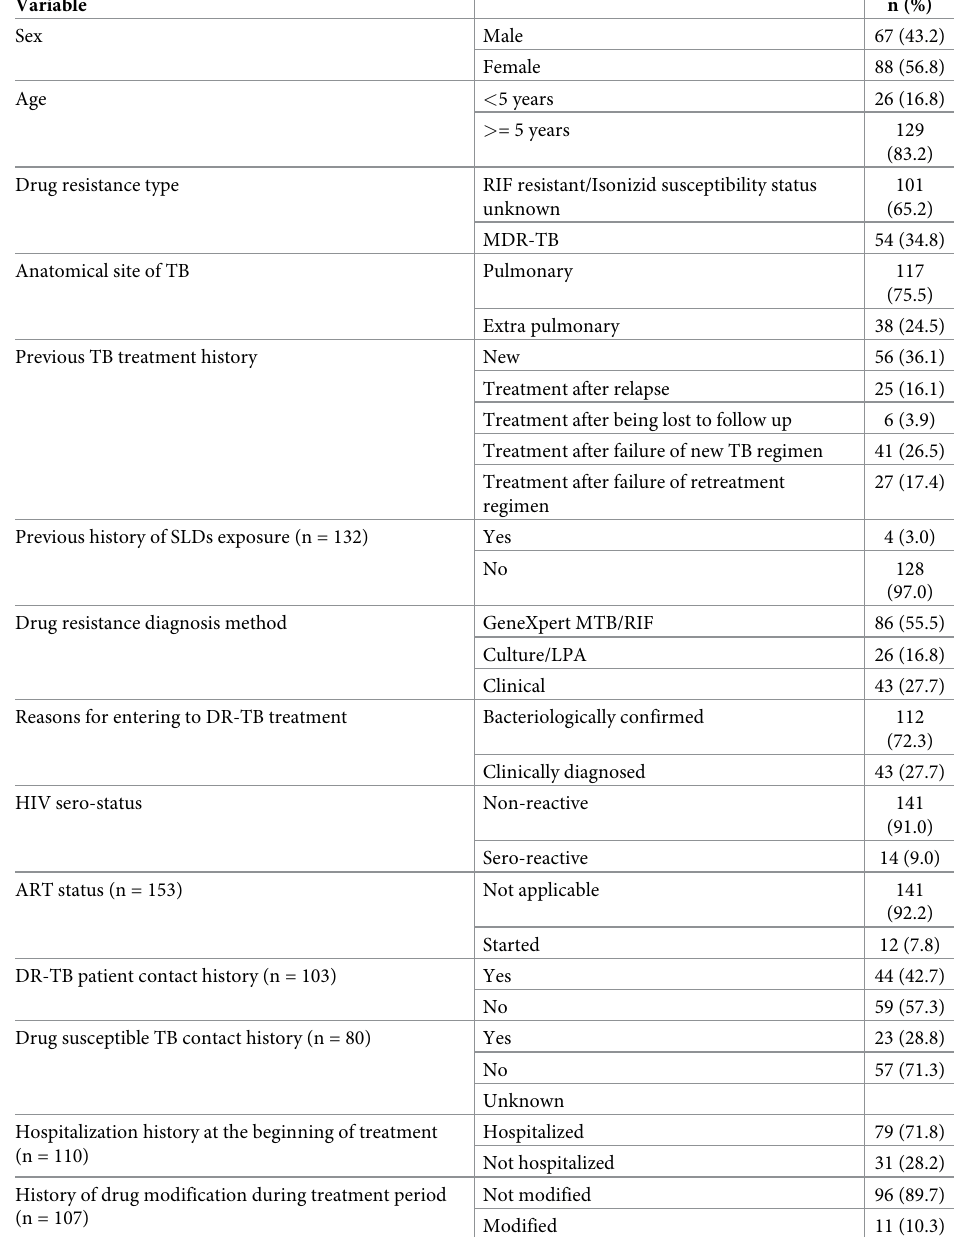
Table 1. Demographic and clinical characteristics of the patients (n = 155 unless